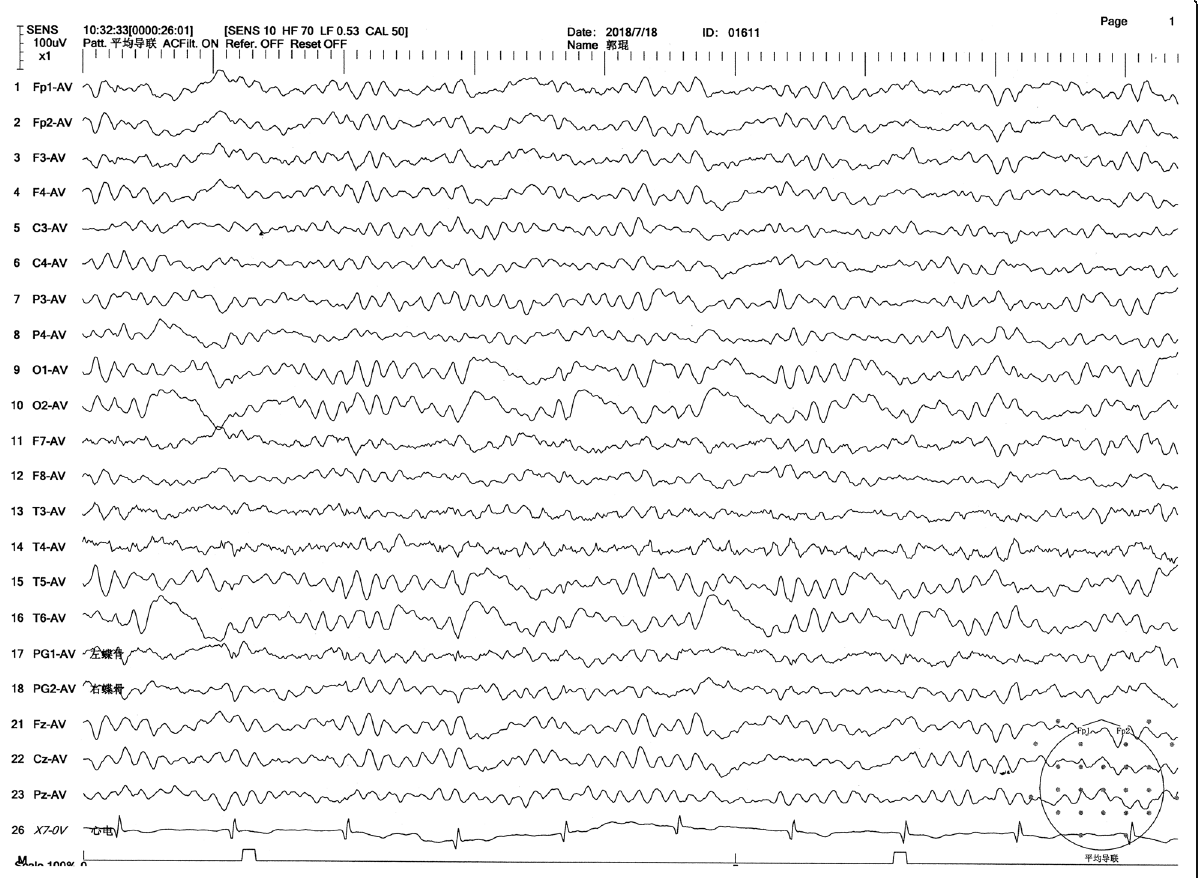
Fig. 7 Scalp EEG shows 2-Hz slow waves on the bilateral occipital and posterior temporal regions (circled region). The slowing was more severe in the right than in the left